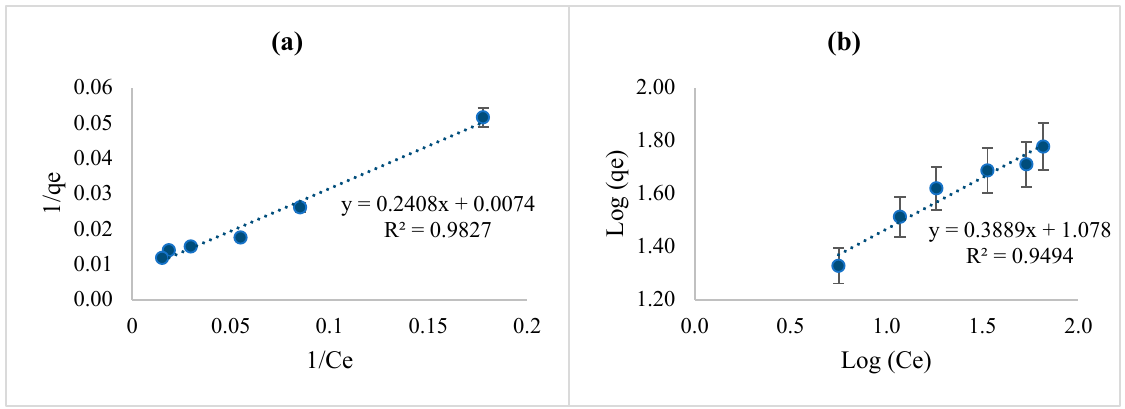
Figure 14. ( a ) Langmuir isotherm of yellow hair dye onto COZ, and ( b ) Freundlich isotherm of yellow hair dye onto COZ.